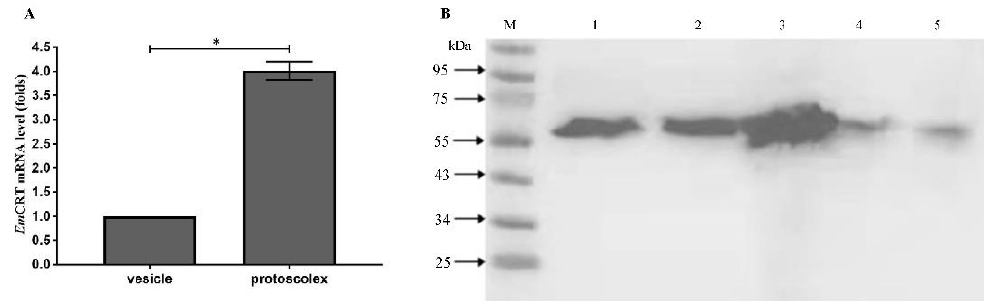
Figure 3. Expression of Em CRT in E. multilocularis metacestode larvae. ( A ) RT-qPCR analysis of transcription level of Emcrt mRNA in PSCs and metacestode vesicle tissue. After being normalized with Emelp , the fold-change of the Emcrt mRNA transcription in PSCs was calculated relative to that in metacestode vesicles. * p < 0.05. ( B ) Analysis of Em CRT protein expression in the lysates of metacestode vesicles (Lane 1), metacestode vesicle fluid (Lane 2), PSCs (Lane 3) and the excretory– secretory products released by cultured metacestode vesicles (Lane 4) and by PSCs (Lane 5) by Western blot with anti-r Em CRT mouse sera. Equal amount of total protein (100 ug), determined by Bradford assay, was loaded for each